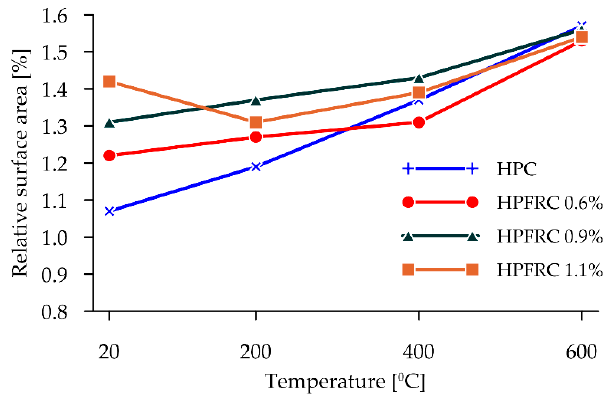
Figure 11. Effect of heating temperature on failure